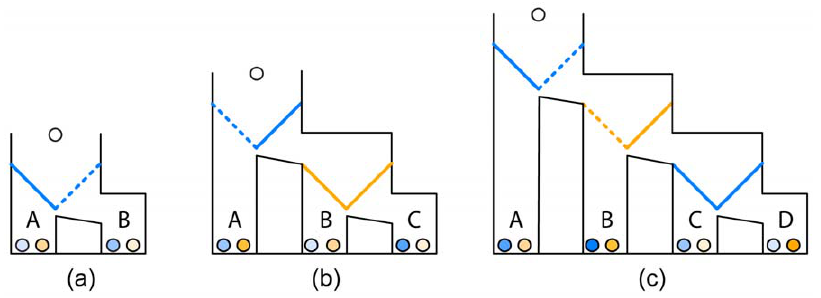
Figure 1. Examples of zero-order (a), first-order (b), and second-order (c) Marble Drop games. Each bin contains a pair of marbles, labeled A to D. For each player, the goal is that the white marble drops into the bin that contains the darkest possible marble of his or her allocated color. In this example, Player 1 9 s marbles are blue, and Player 2 9 s marbles are orange. Player 1 controls the blue trapdoors and Player 2 controls the orange trapdoors. The dashed diagonal lines represent the trapdoors that the players should decide to remove to obtain their maximum payoffs in these particular games.